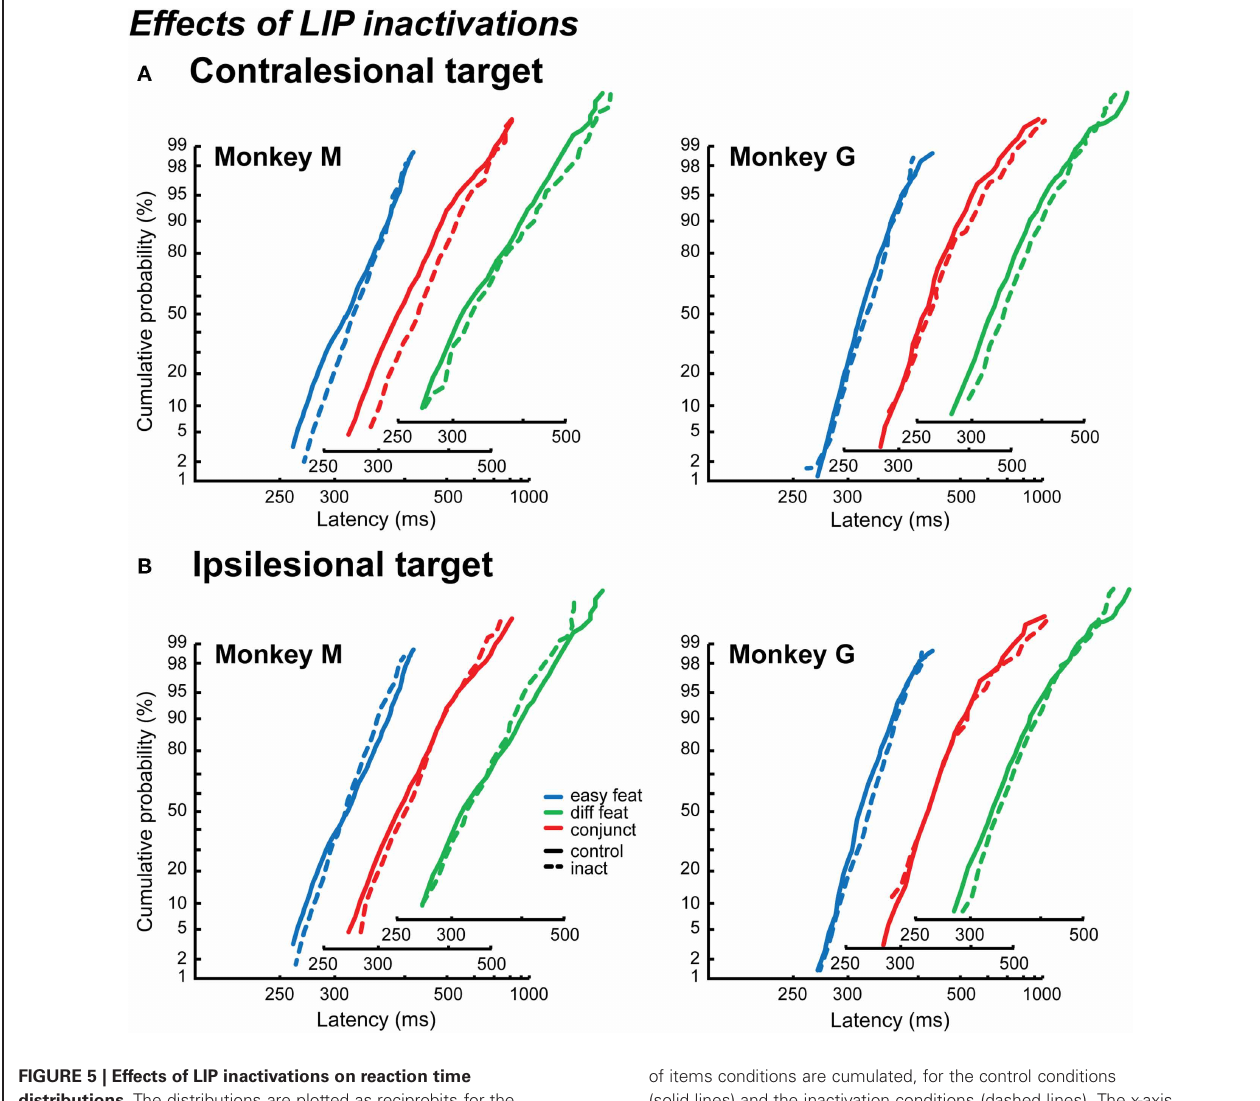
FIGURE 5 | Effects of LIP inactivations on reaction time distributions. The distributions are plotted as reciprobits for the contralesional targets (A) and the ipsilesional targets (B) , in Monkey M (left) and Monkey G (right). The different numbers